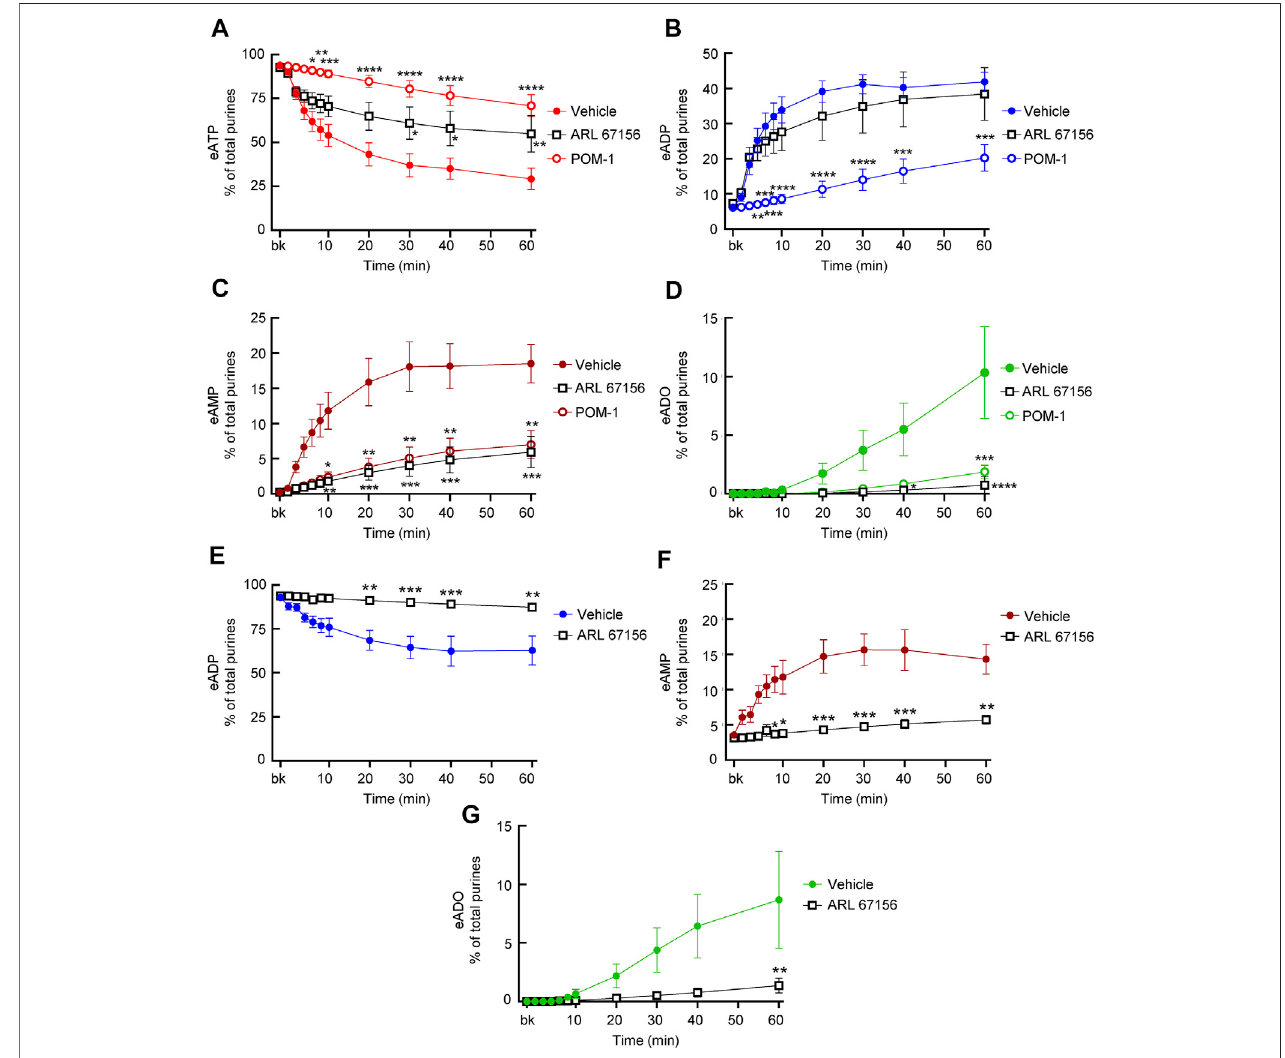
FIGURE7| EffectsofARL67156andPOM-1onhydrolysisofeATPbysolubleenzymesinLP. (A – D) eATPinthepresenceofvehicle(KBS)orARL67156(100 µM) or POM-1 (100 µM). (E – G) eADP hydrolysis by soluble enzymes in the presence of vehicle (KBS) or ARL67156 (100 µM). Asterisks denote signi fi cant difference from vehicle controls. * p < 0.05, ** p < 0.01, *** p < 0.001, **** p < 0.0001.